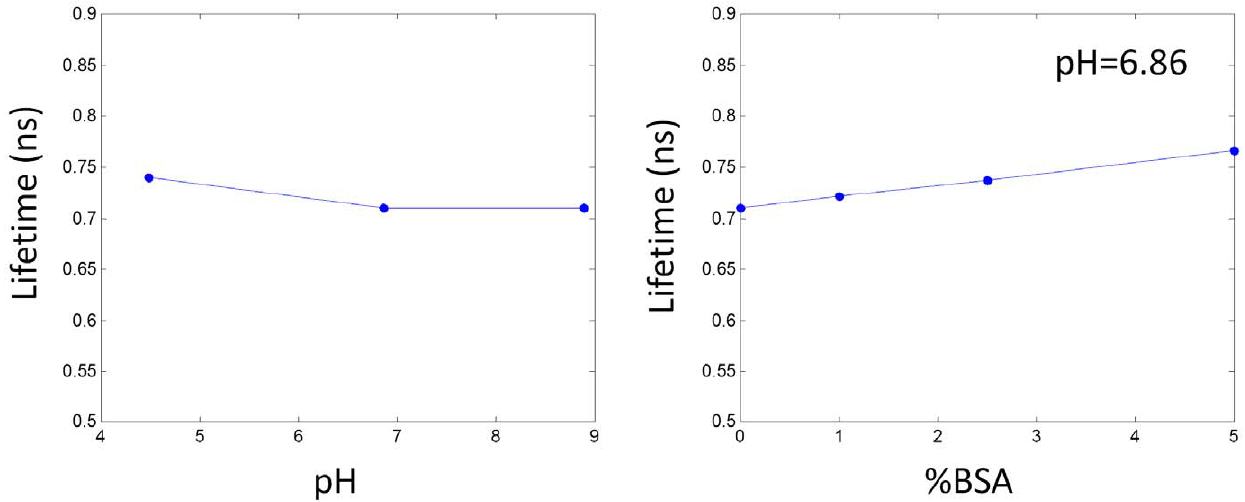
Figure 1. Effect of (A) pH and (B) BSA concentration on the lifetime of DyLight750 conjugated to HER2 specific Affibody probe.